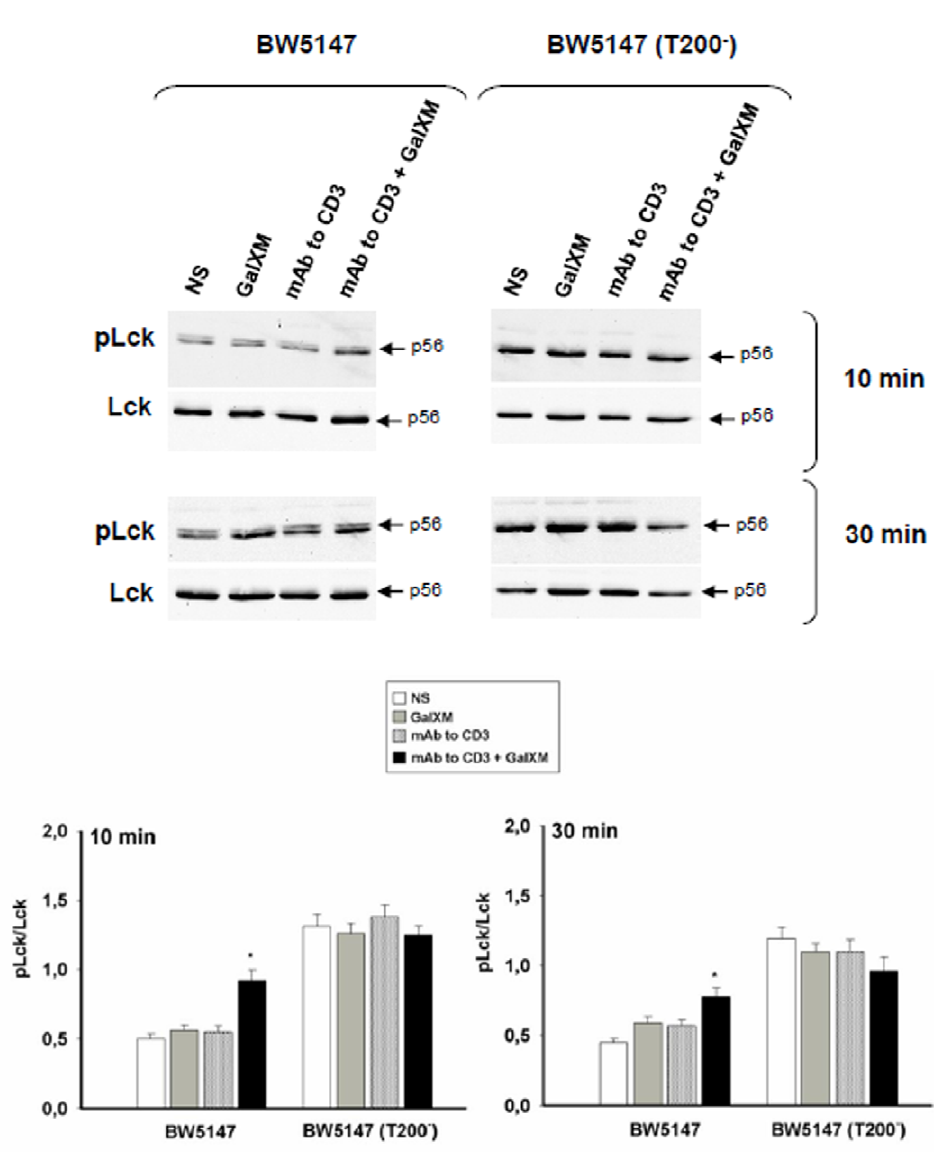
Figure 5. Phospho-Lck activation on BW5147 cells treated with GalXM. BW5147 and BW5147 (T200 2 ) cells (both 5 6 10 6 /ml) were pre- activated for 30 min in the presence or absence (NS) of mAb to CD3 (1 m g/ml) and then incubated for 10 or 30 min in the presence or absence (NS)